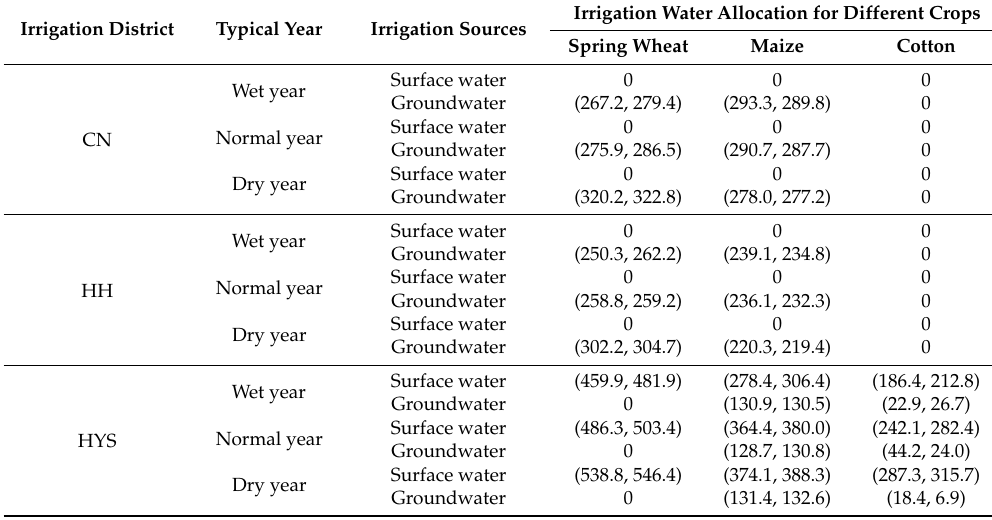
Table 4. Optimal irrigation water allocation in different scenarios